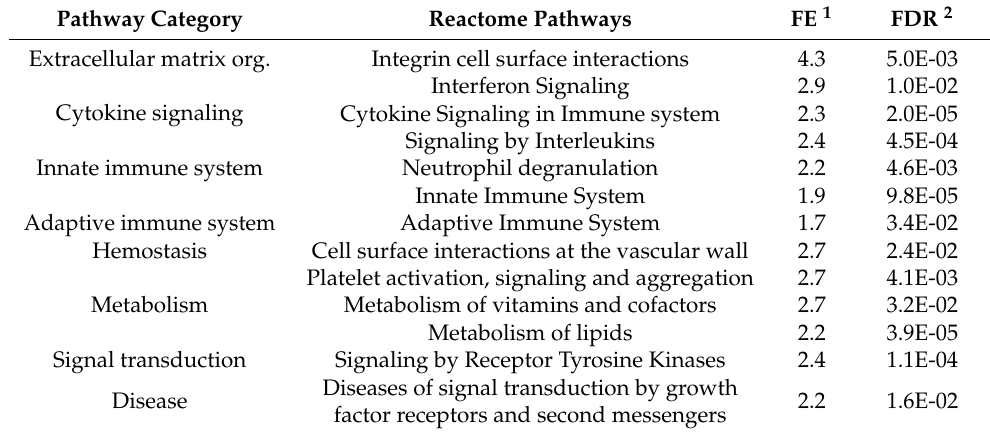
Table 4. Enriched gene